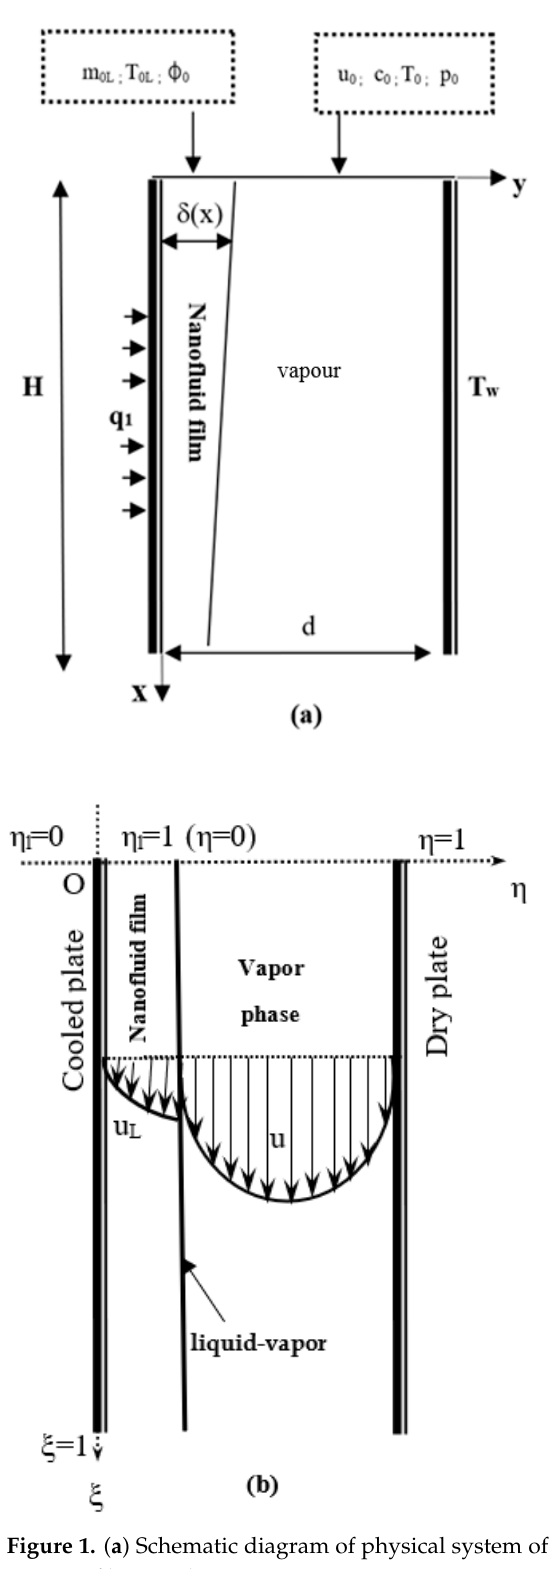
Figure 1. ( a ) Schematic diagram of physical system of heat exchanger; ( b ) Domain of the physical Figure 1. The physical system of heat exchanger on ( a ) heated and wetted, and ( b ) isothermal and system of heat dry.